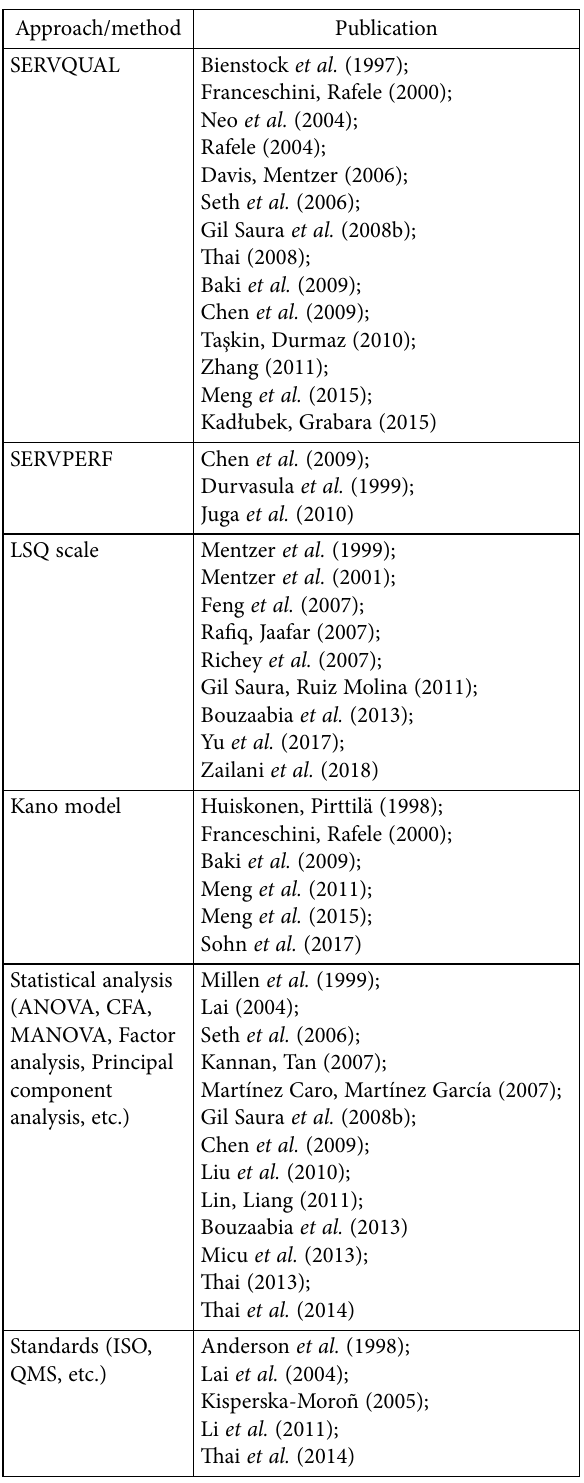
Table 4. Approaches and methods for the measuring of LSQ